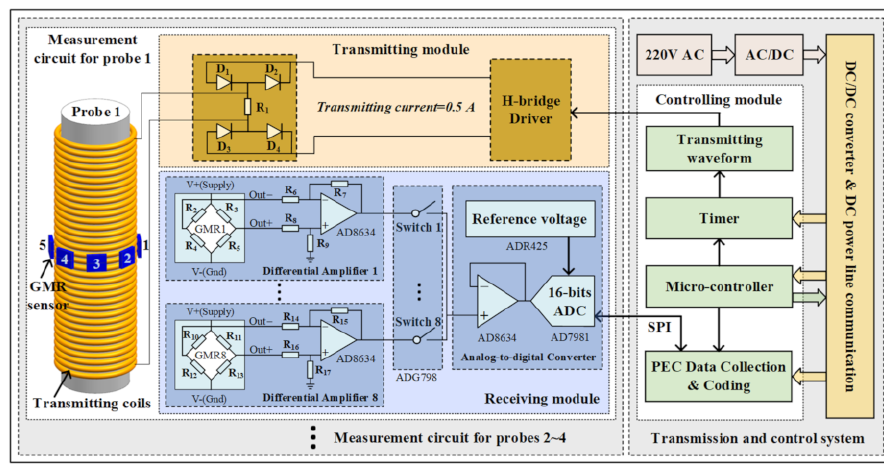
Figure 4. Borehole PEC circuits for the synthesized